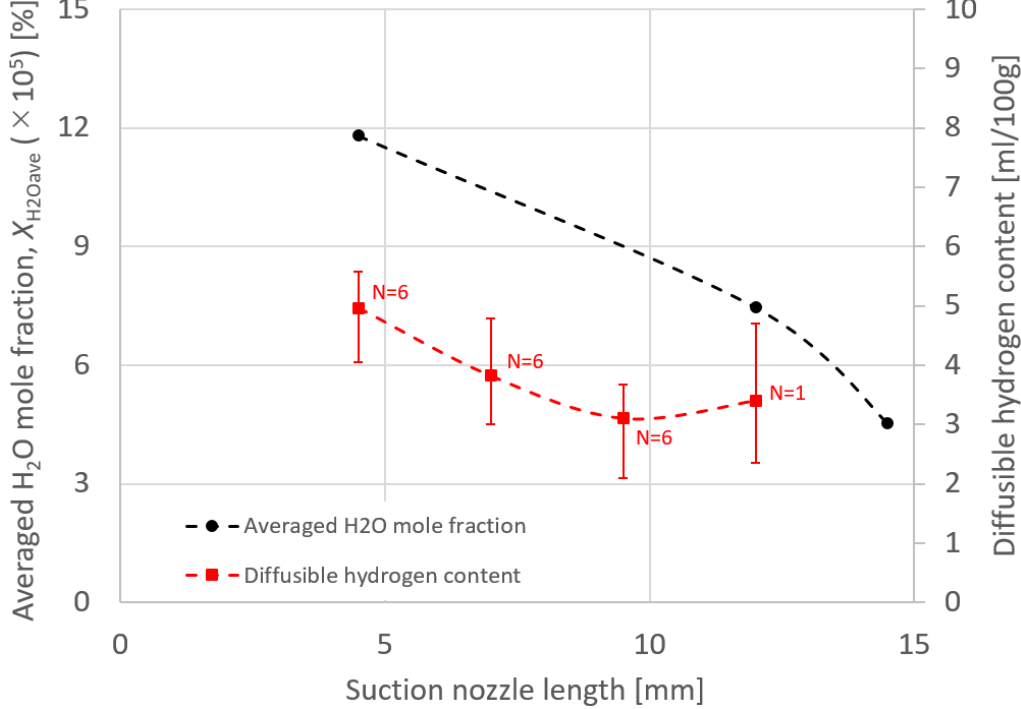
Figure 17. The measured diffusible hydrogen content and the averaged H 2 O mole fraction as a function of suction nozzle length.